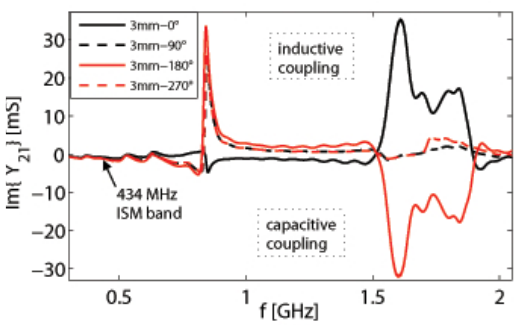
Figure 11. Measured angular variation of transmission susceptance Im( Y 21 ) in large frequency scale for a 3mm gap.